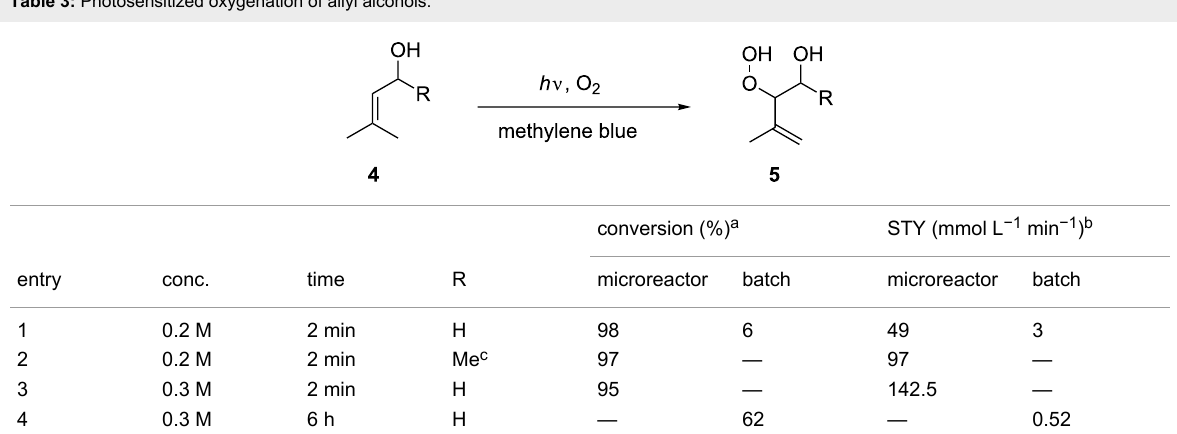
Table 3: Photosensitized oxygenation of allyl